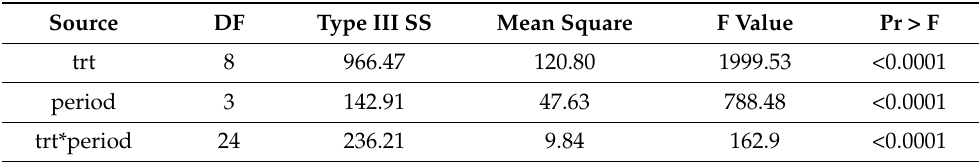
Table 6. Showing significant influence of cement type and time duration on water-solubility (WSL %) of the cements tested